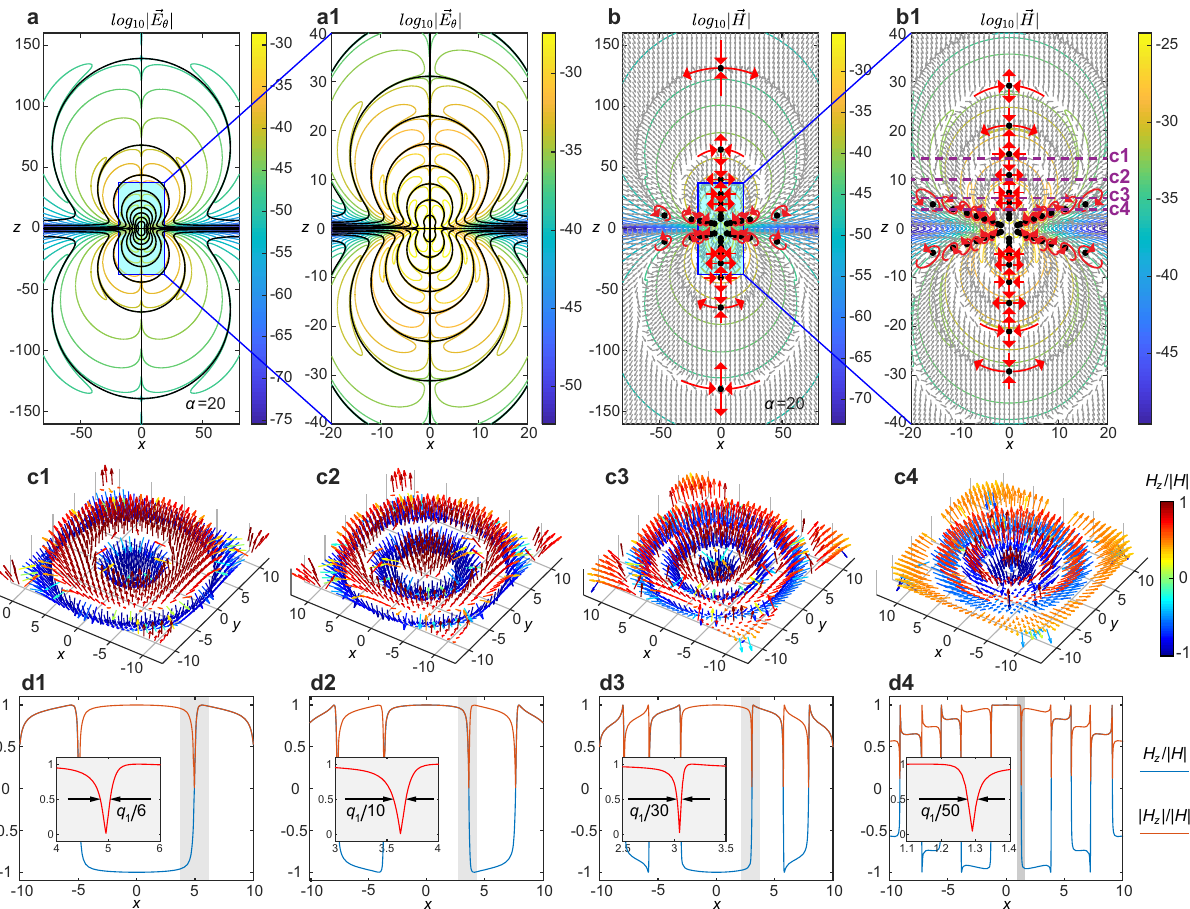
Fig. 5 Fractal-like patterns in electromagnetic fi elds of supertoroidal pulses. a The isoline plot of the electric fi eld in the x – z plane for the STLP of α = 20, Re ½ E ð α ¼ 20 Þ θ ð r ; t ¼ 0 Þ(cid:3) , in logarithmic scale. Electric fi eld zeros are marked by the black solid lines and black dots. Panel a1 presents the zoom-in plot of region highlighted by blue box in ( a ). b The isoline plot of magnetic fi eld amplitude (in logarithmic scale) and arrow plot of normalized magnetic vectors in the x – z plane for the STLP of α = 20. Magnetic fi eld singularities are marked by black dots with red arrows correspondingly marking the saddle or vortex style of the vector singularities. Panel b1 presents the zoom-in plot of region highlighted in ( b ). Subwavelength features of skyrmionic structures: c1 – c4 The skyrmionic distributions of magnetic fi eld at several transverse planes marked by dashed lines marked by “ c1 – c4 ” in ( b1 ). d1 – d4 The distribution of normalized magnetic fi eld and its absolute value versus x for the skyrmionic structures in c1 – c4 . Insets illustrate the Subwavelength features at the regions highlighted by gray bands. Unit for coordinates: q 1